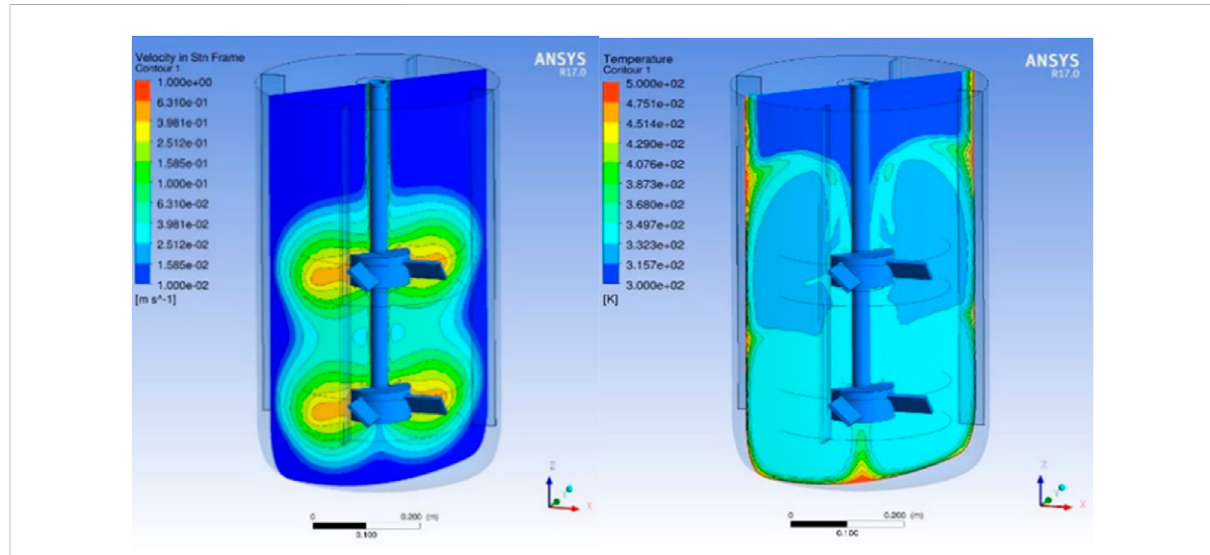
FIGURE 1 CFD analysis of a zeolite synthesis gel in a stirrer autoclave during zeolite